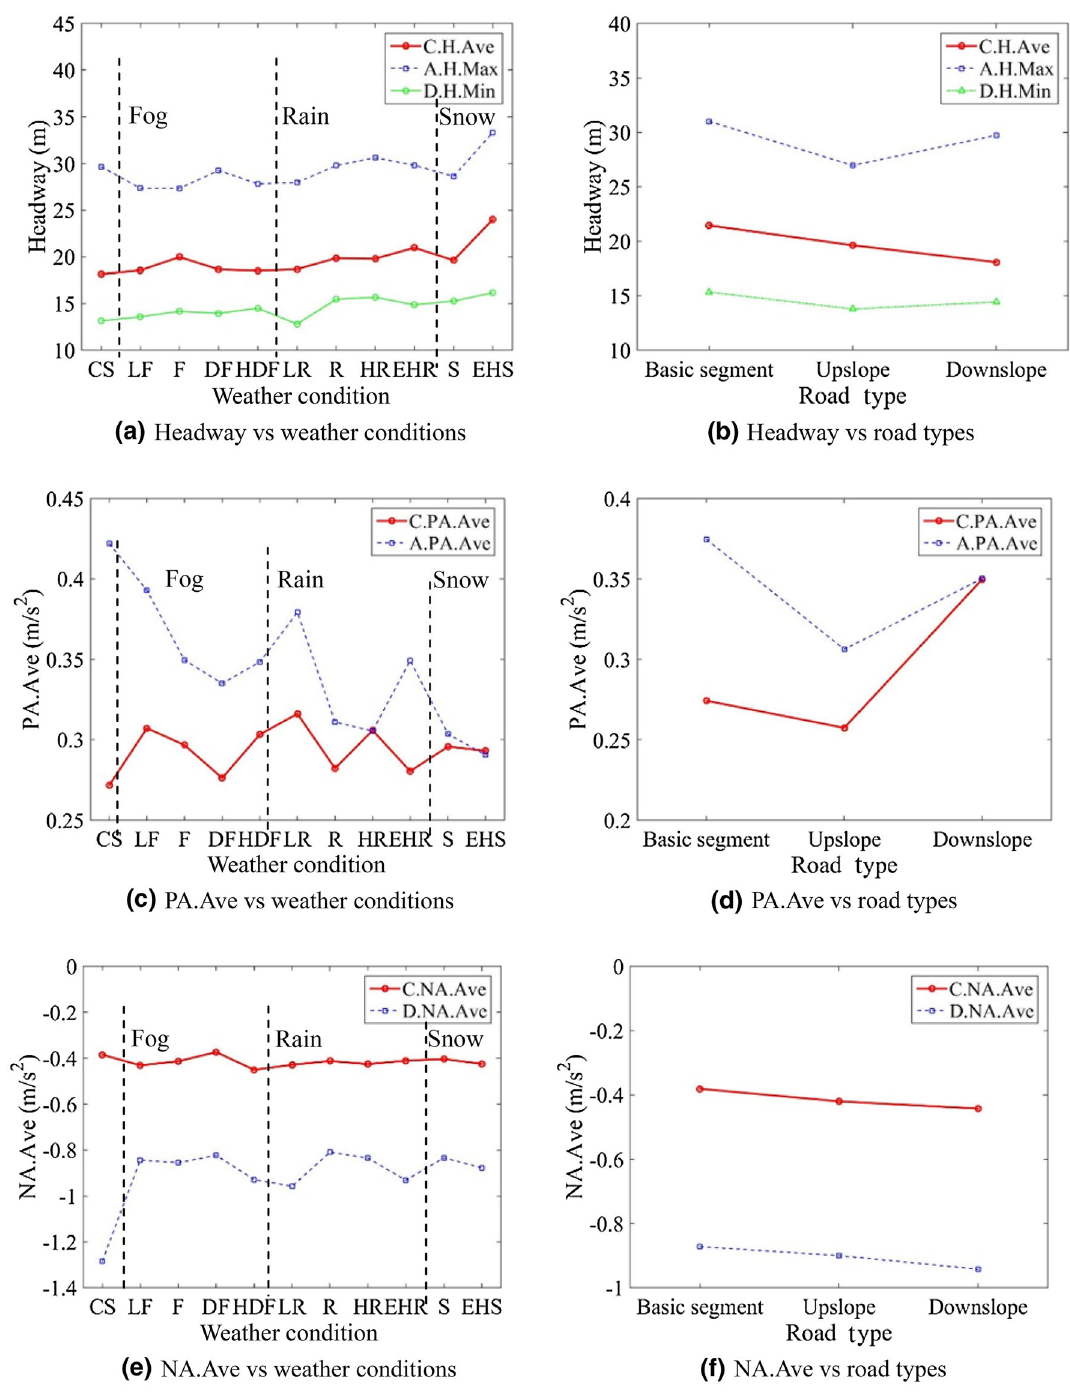
Fig. 5 Influence of weather conditions and road types o